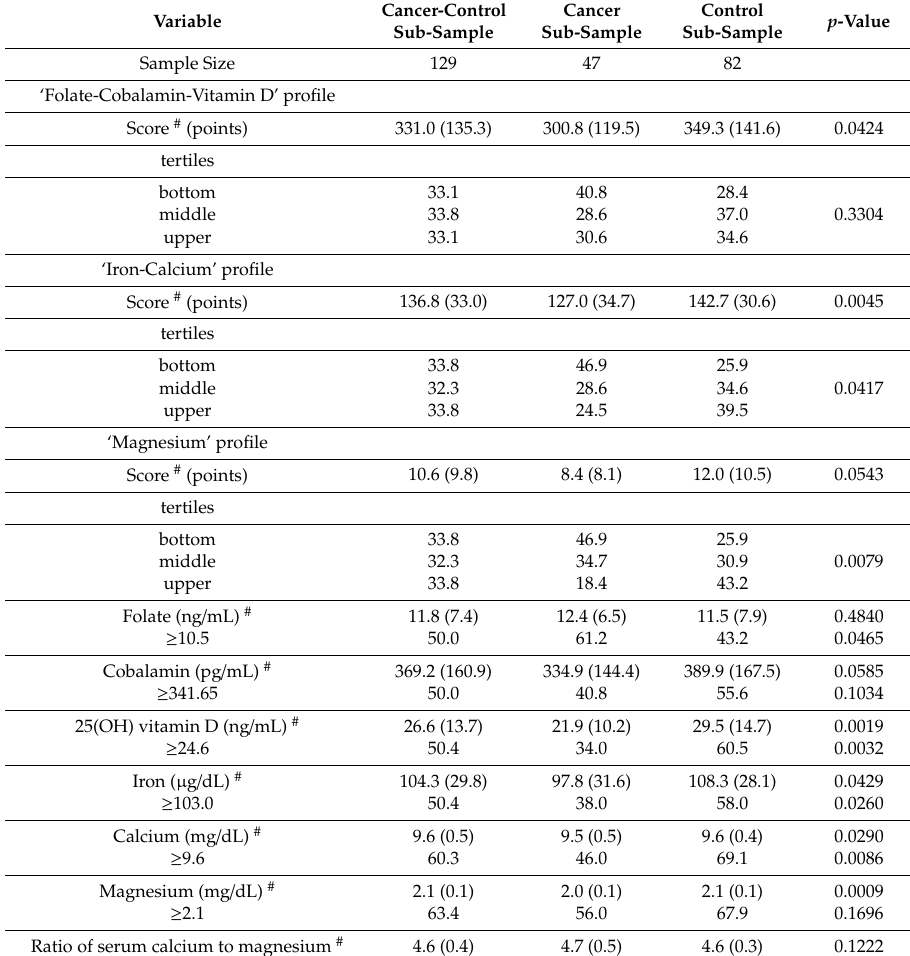
Table 8. Serum vitamin-mineral profiles and their components in association with breast cancer (% or